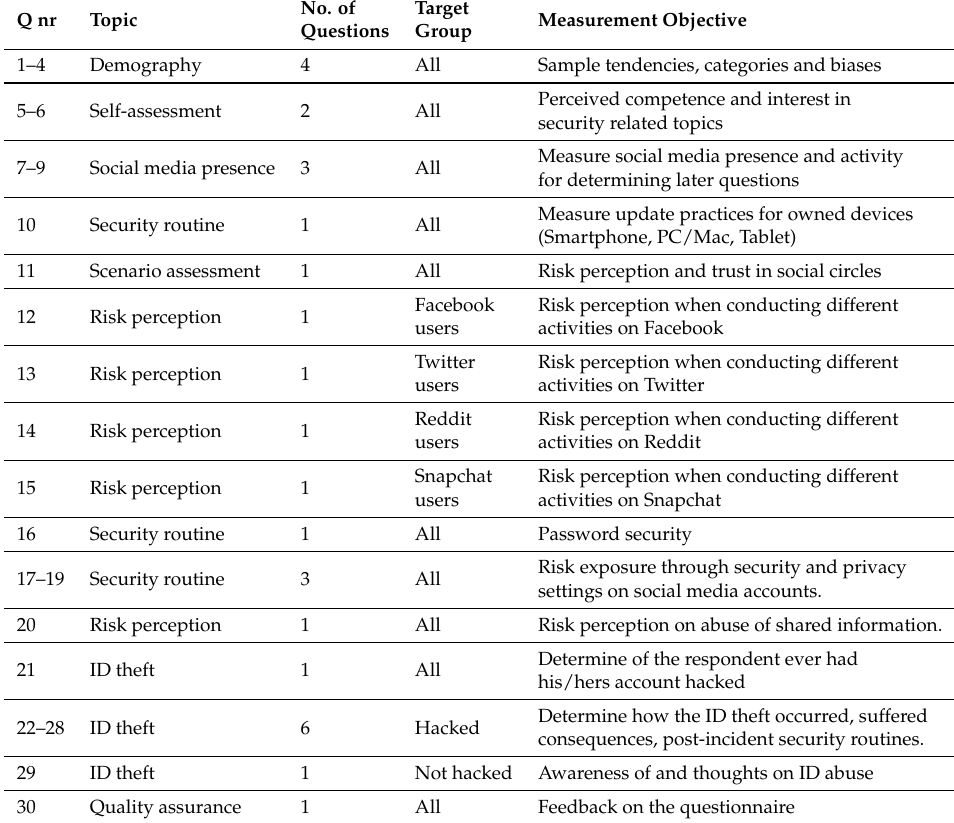
Table 1. Summary of the questionnaire: No of questions per topic, target group and measurement objective per question